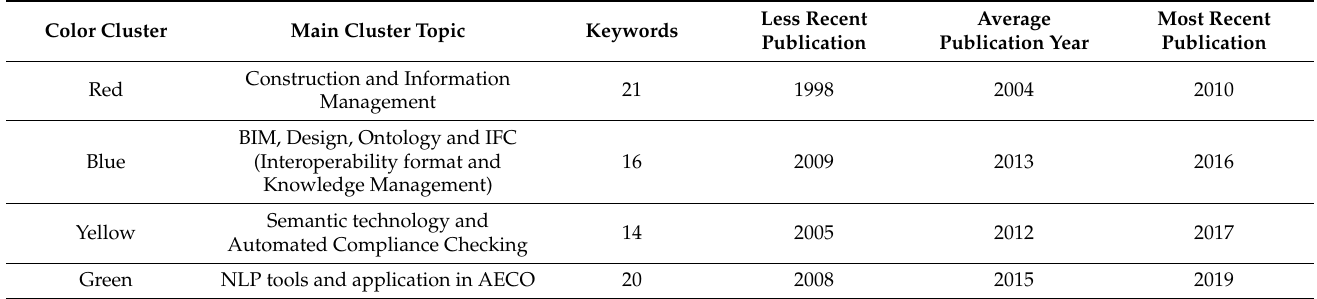
Table 4. Cluster topic average publication year.